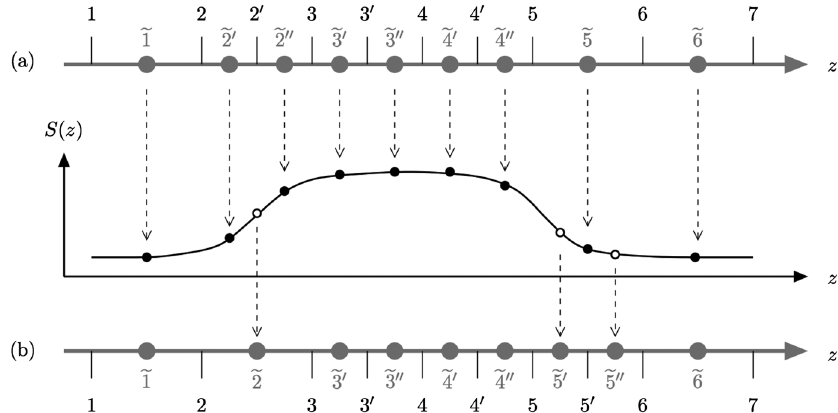
FIG. 8. Setup and evaluation of the interpolating spline. An exemplary arrangement of grid nodes along the z coordinate is shown in (a) and (b). In (b) the refined area of the grid has moved by a distance of one grid cell into the z direction. Hence, the grid has to be coarsened around node 2 and refined around node 5. The interpolating spline is set up, using the position of the nodes and field data in the refined area and some neighboring cells (black dots). An evaluation of the spline function at the position of new or shifted nodes (circles) yields the interpolated field